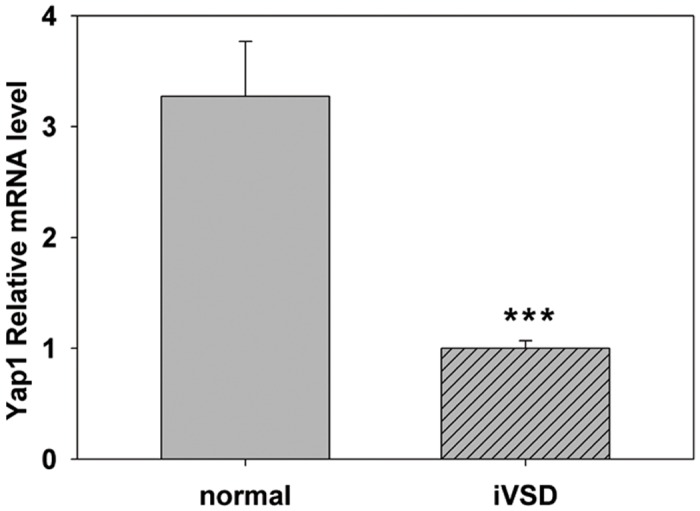

YAP1 mRNA is significantly lower in iVSD hearts compared to control hearts.Quantitative RT-PCR was used to analyze message levels of YAP1 in iVSD and control hearts. Our results indicate that YAP1 is significantly decreased in iVSD samples compared to normal controls. GAPDH served as a control. Bars indicate means ± SD. The Student’s t _test was performed to evaluate statistical significance, iVSD group: n = 20; control group: n = 6, ***p<0.001.